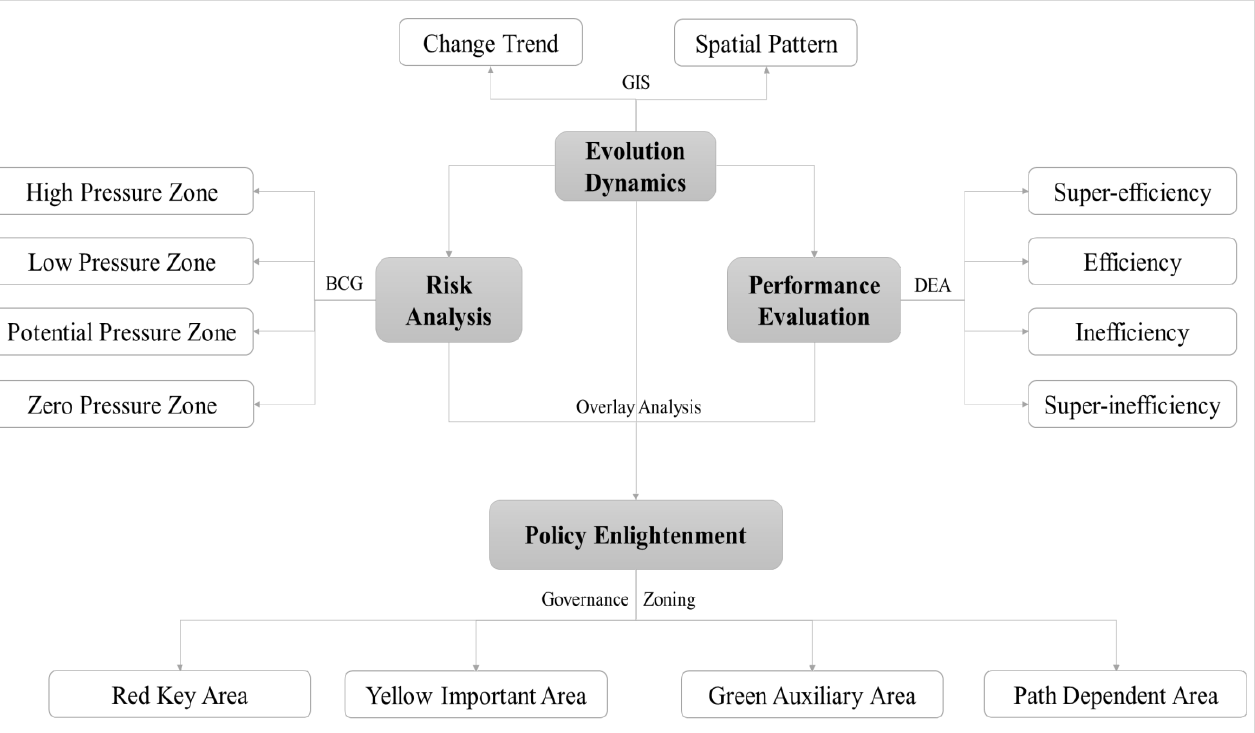
Figure 2. Research